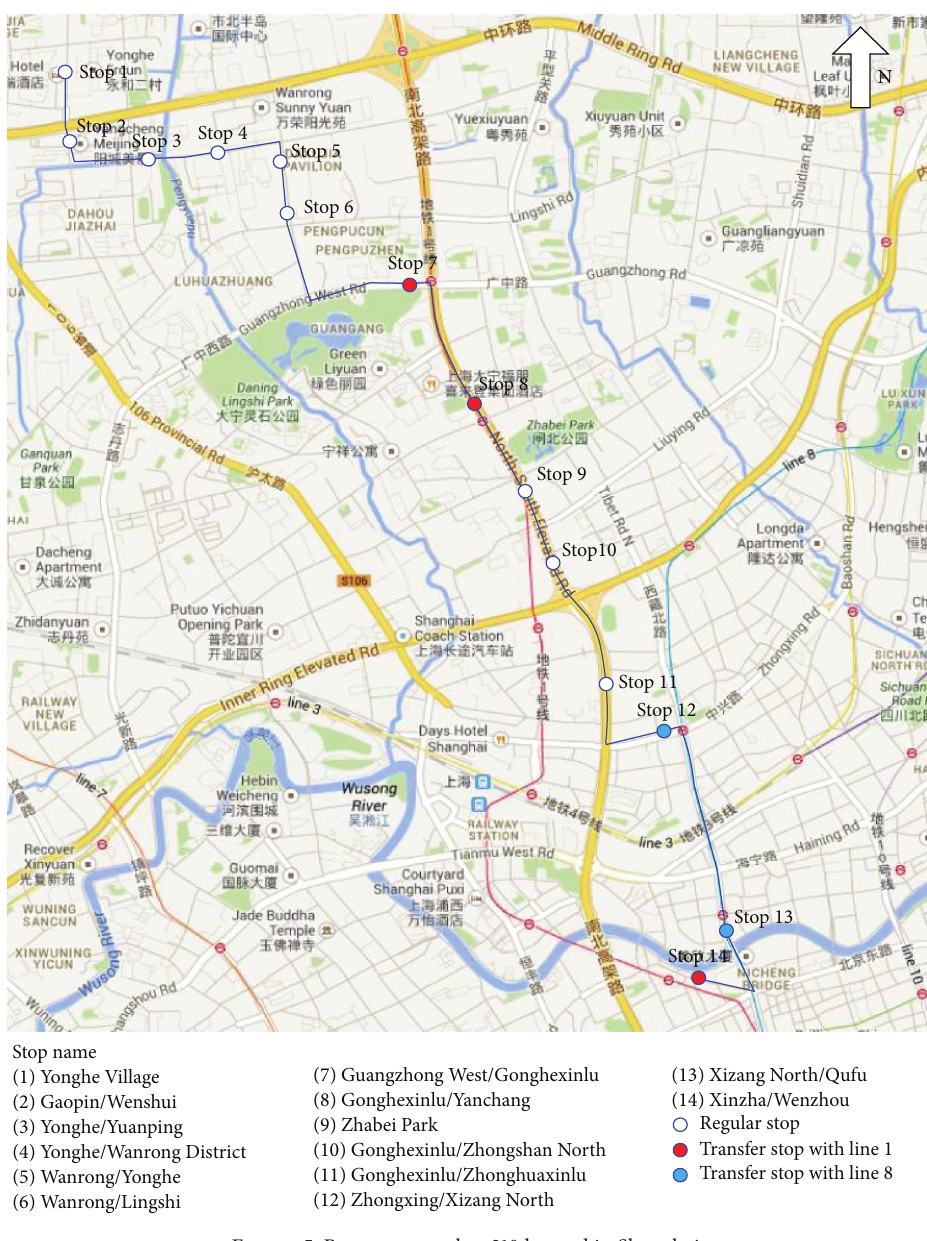
Figure 5: Bus route number 210 located in